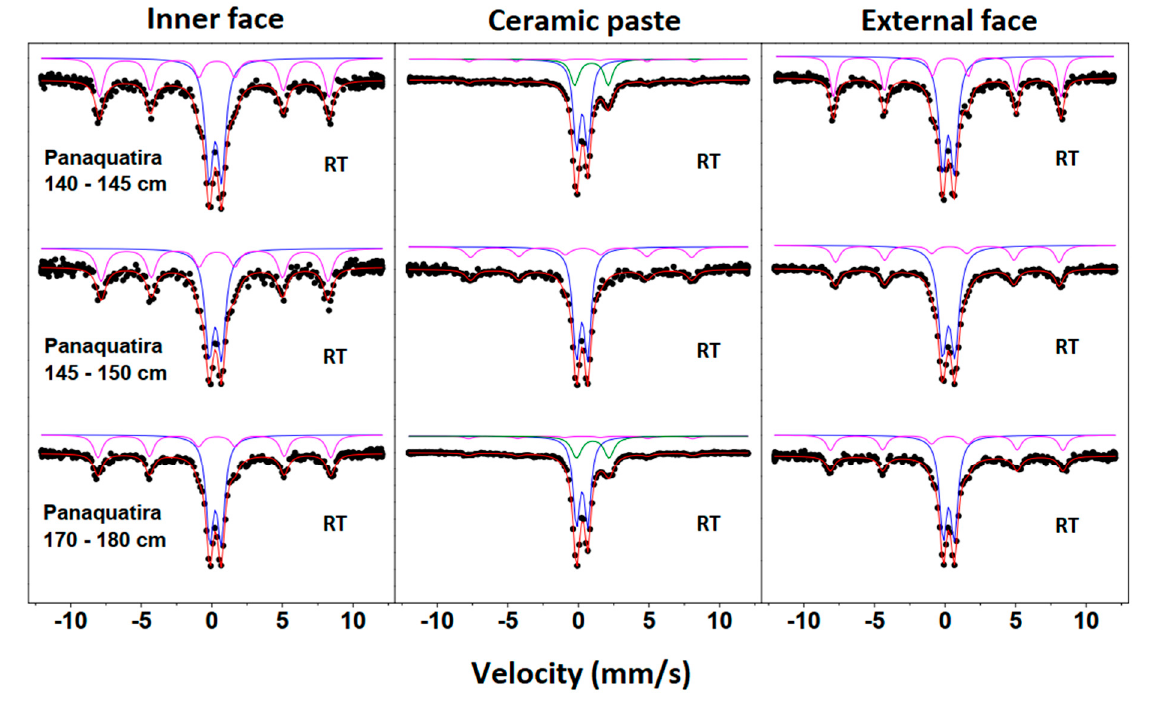
Figure 5. Panaquatira samples Mössbauer spectra. The blue and green spectra represent the quad- rupole doublets of Fe 3+ and Fe 2+ , respectively. The pink spectrum represents the magnetic sextet of hematite. The red spectrum is the superposition of the magnetic components present in the sample. Table 2. Hyperfine parameters obtained at room temperature (IS: isomer shift; QS: quadrupole split- ting; B hf : hyperfine field, and A: relative area of the different Fe species).